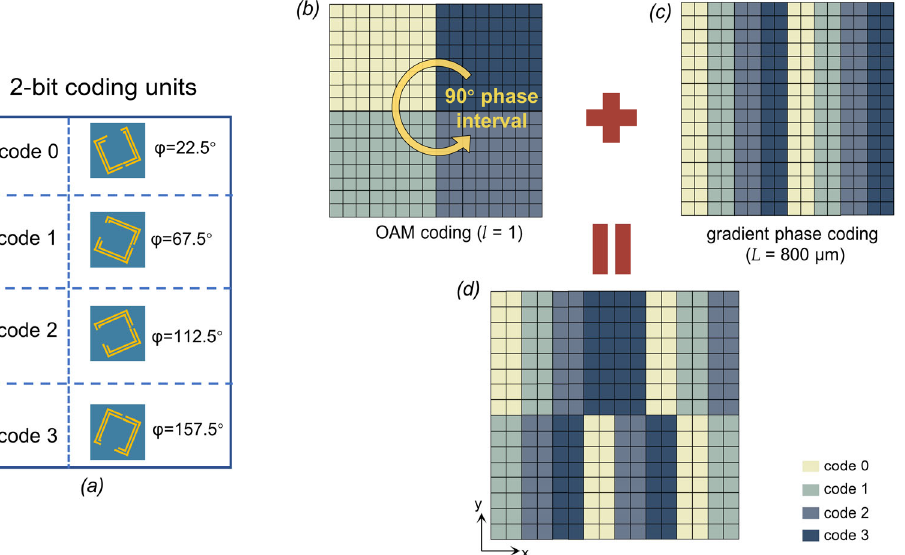
Figure 8. 2 ‐ bit coding scheme of the spin ‐ selective vortex beam generator with an anomalous reflec ‐ Figure 8. 2-bit coding scheme of the spin-selective vortex beam generator with an anomalous tion angle. ( a ) Four basic 2 ‐ bit coding units; ( b ) Coding strategy with OAM mode l = 1; ( c ) Coding reflection angle. ( a ) Four basic 2-bit coding units; ( b ) Coding strategy with OAM mode l = 1; strategy with gradient coding sequence “00112233 ∙∙∙ ” varying along the x direction and the phys ‐ ( c ) Coding strategy with gradient coding sequence “00112233 ··· ” varying along the x direction and ical length of the phase gradient L = 800 μ m; ( d ) The mixed coding strategy based on phase super ‐ the physical length of the phase gradient L = 800 µ m; ( d ) The mixed coding strategy based on phase position of b and c. superposition of b and